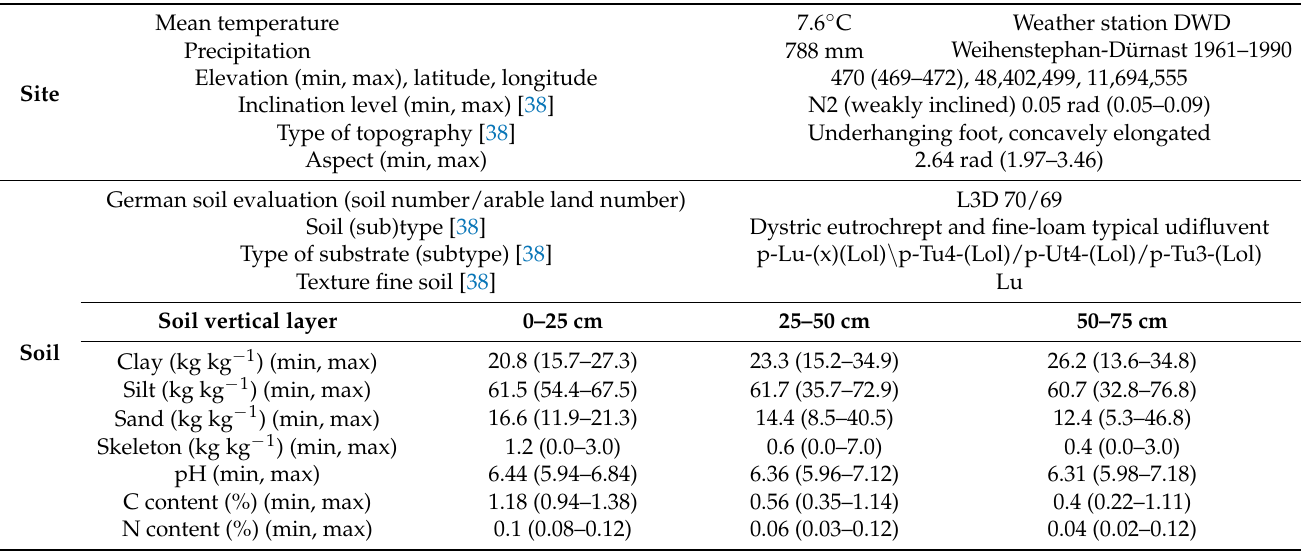
Table 2. Site description of the long-term nitrogen fertilization experiment Dürnast 020 [6,38]. Mean Site